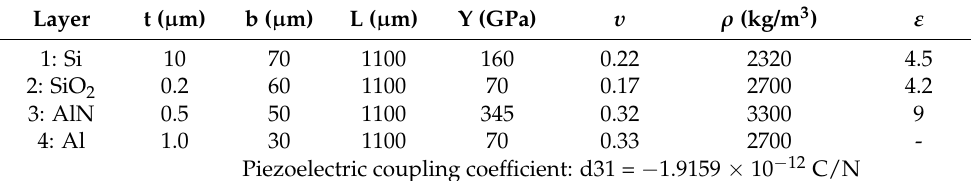
Table 2. Geometry and material parameters of the piezoelectric resonator.